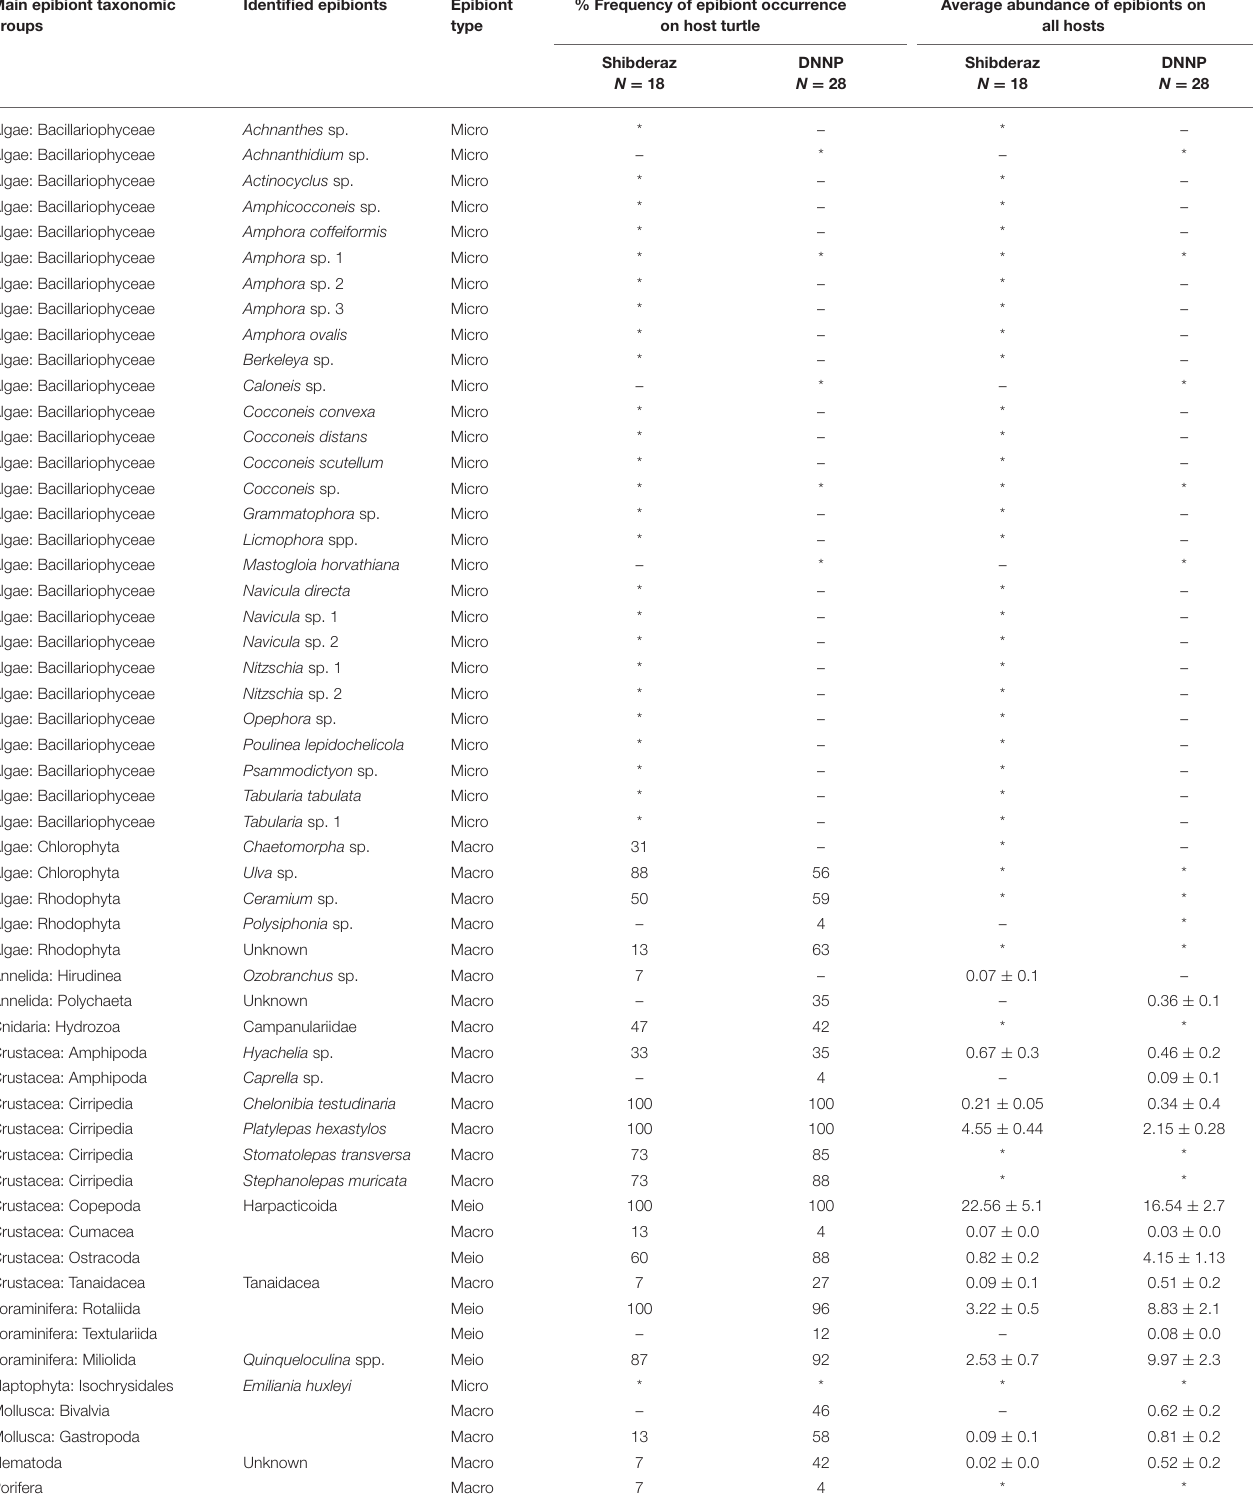
TABLE 2 | Epibiont species list, abundance (ind. per 9 cm 2 ), and frequency of occurrence on hawksbill ( Eretmochelys imbricata ) turtles ( N = 46) nesting on Shibderaz (Qeshm Island) and Dayyer-Nakhiloo National Park (DNNP; Bushehr) beaches,